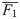
Ranking of the six estimation procedures according to the Friedman-Nemenyi test.The average ranks are computed from absolute errors, measured by F1¯. The black bar connects ranks that are not significantly different at the 5% level.